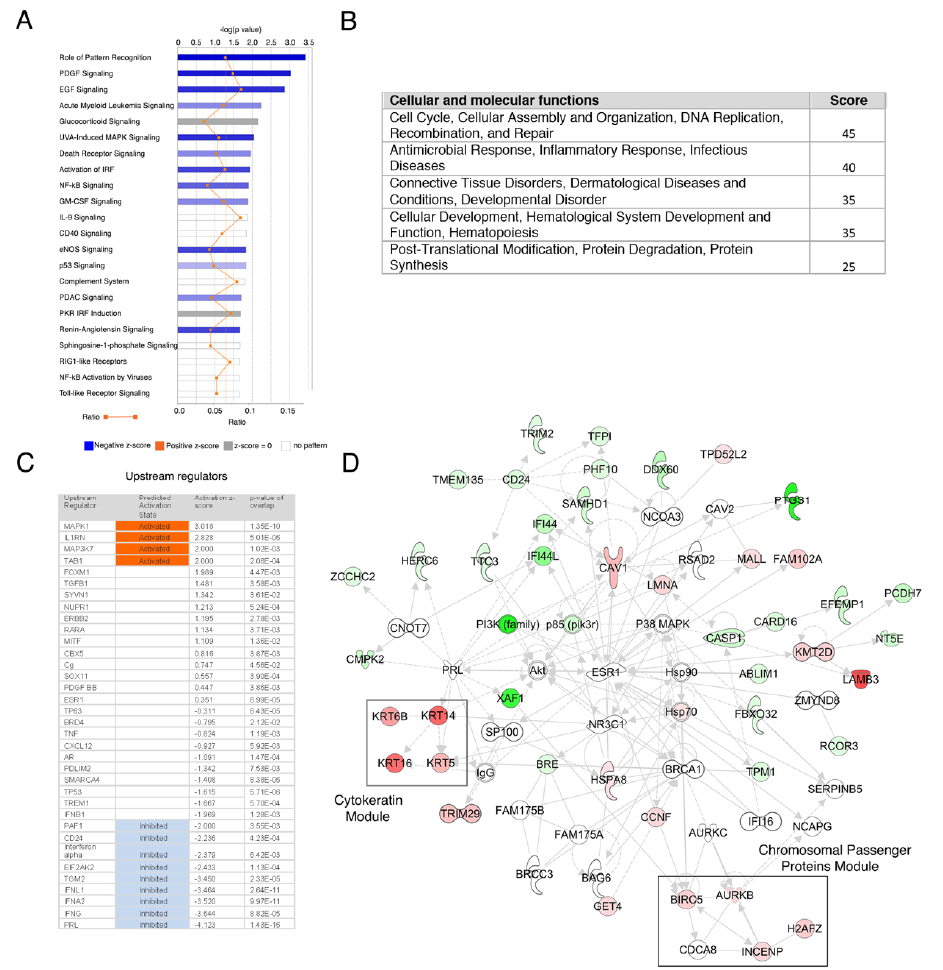
Figure 2. Network analysis of DE genes in CSCs from MDA-MB-468 cells. ( A ) Significant signaling cascades in the studied set. Bars length depicts the -log ( p value) of each cascade, the color of the bar represents the z-score and the orange line points the ratio of genes in the pathway (e.g., the proportion of the studied DE genes present in each signaling cascade). ( B ) Enriched cellular and molecular functions table. The main functions and scores are shown. ( C ) Upstream regulators. The table shows the upstream regulator gene, the predicted activation (based on an absolute score > 2) and the p value of the gene overlap. ( D ) Main network in CSCs, showing two important modules in squares (Cytokeratin module and Chromosomal Passenger module). Red represents increased expression of the molecule in CSCs and green decreased expression.